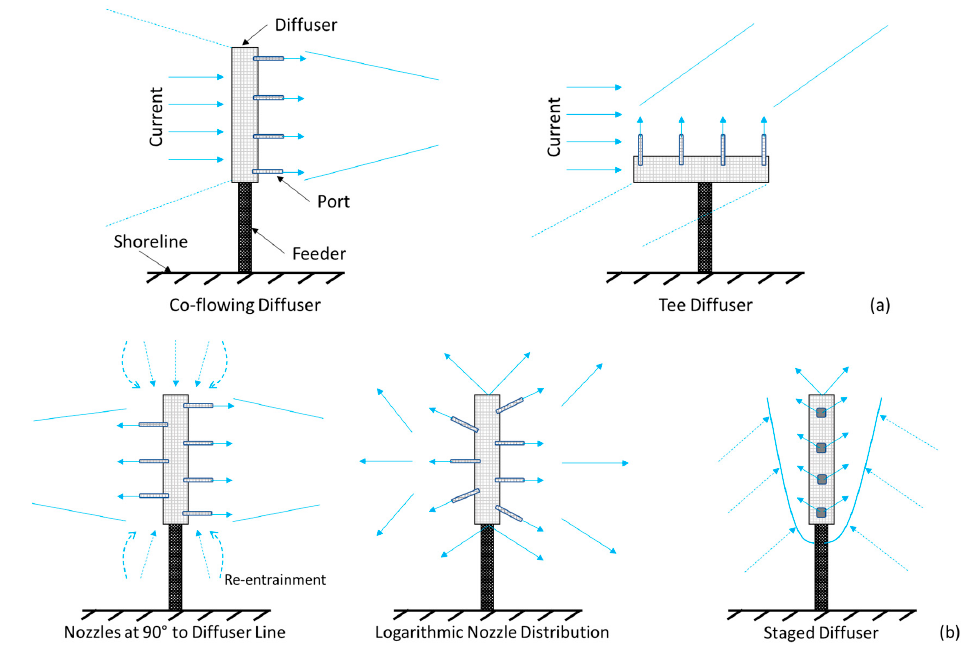
Figure 14. Multiport diffusers. ( a ) unidirectional diffusers with cross-flow, ( b ) alternating diffuser.